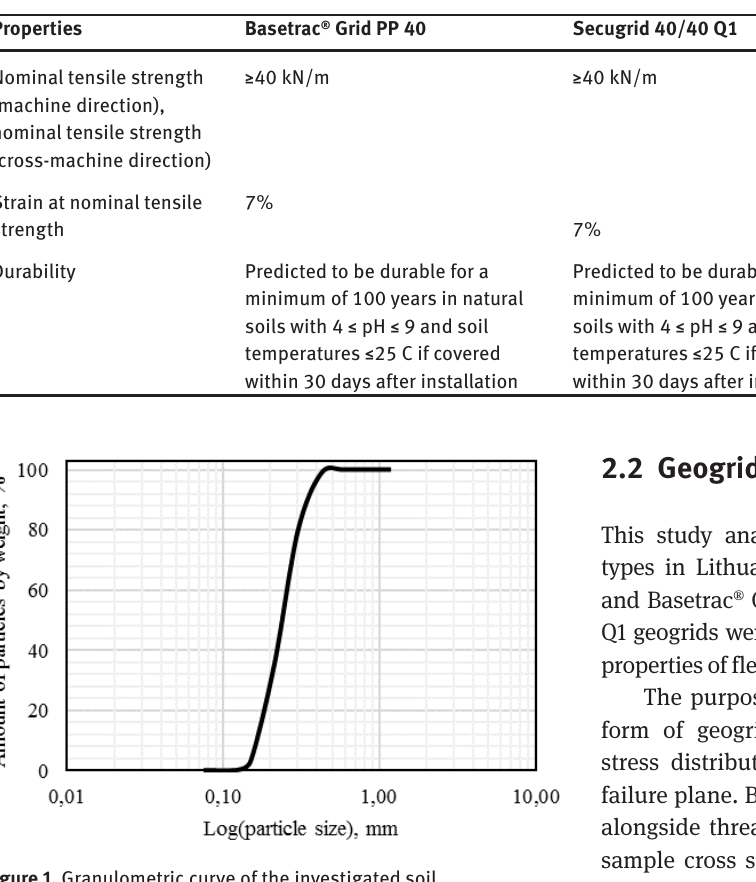
Figure 1. Granulometric curve of the investigated soil.